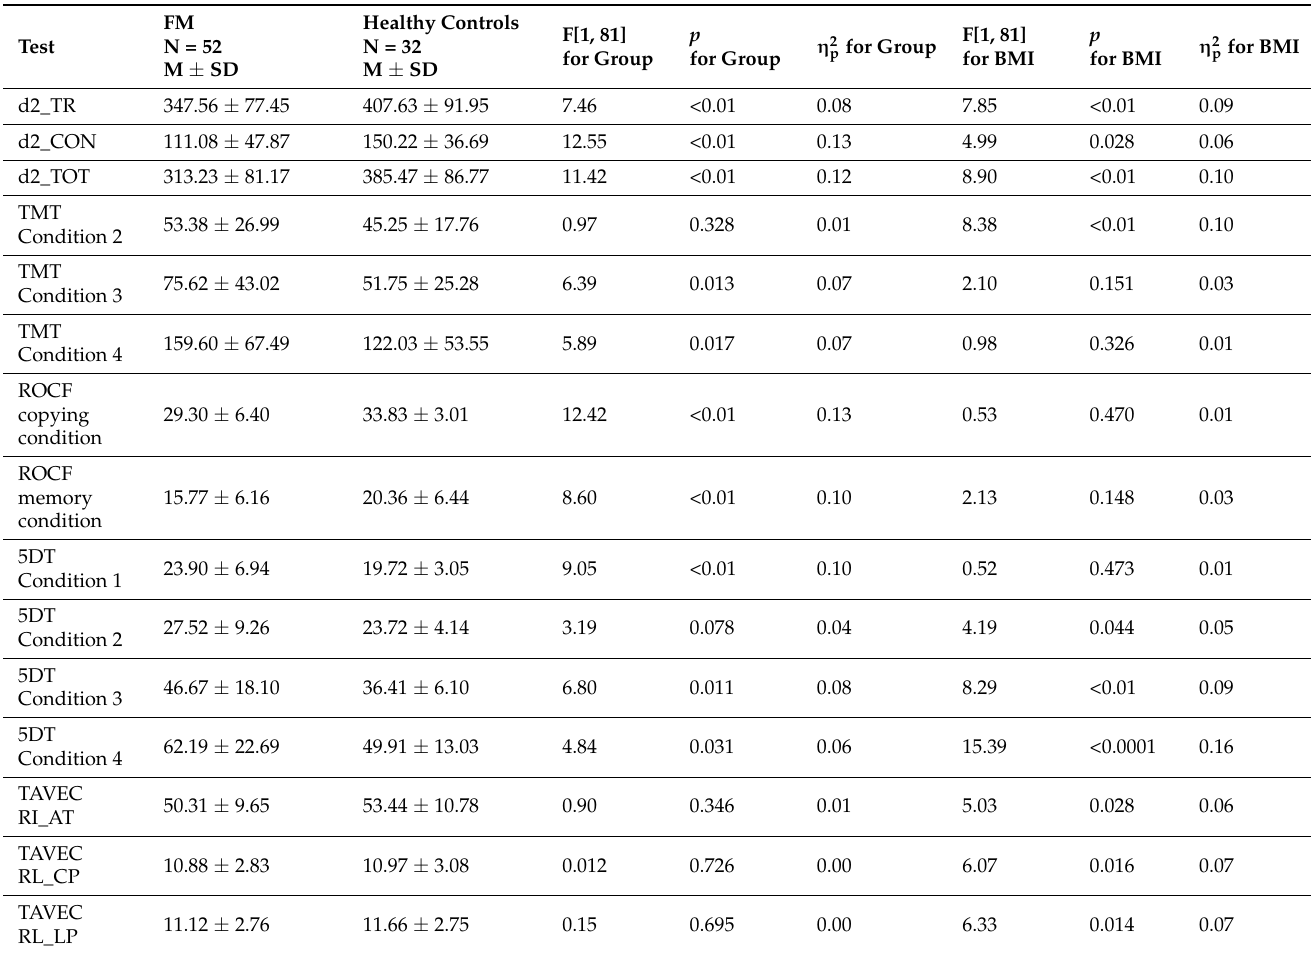
Table 2. Means (M) and standard deviations (SD) of cognitive performance parameters for the FM patients and healthy controls: F, p and η 2 p values indicating the main effects of group and body mass index (BMI) are also